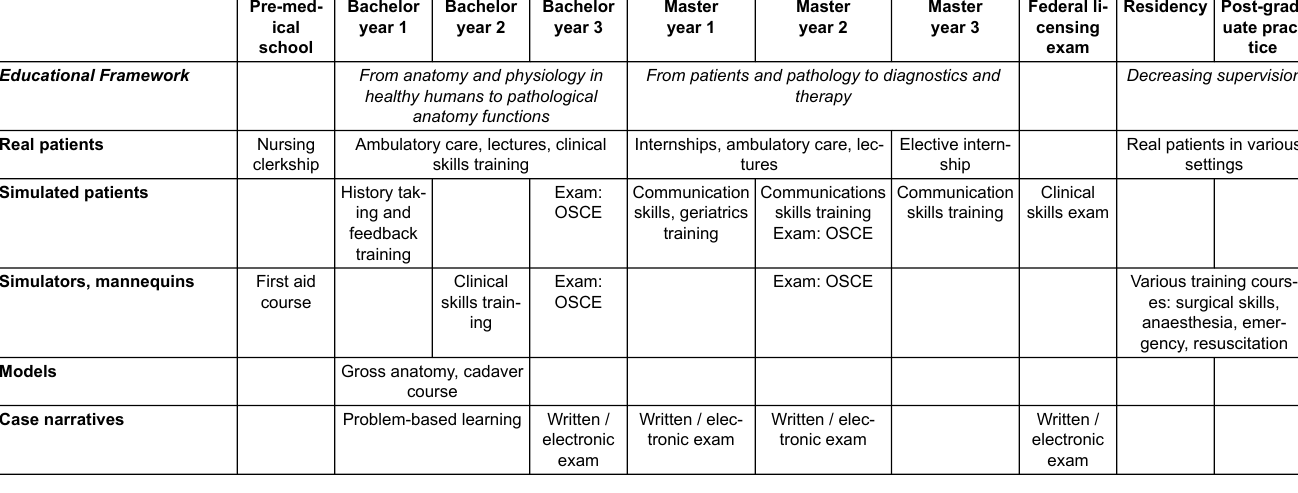
Table 1: Examples of patient representations during a Swiss medical education